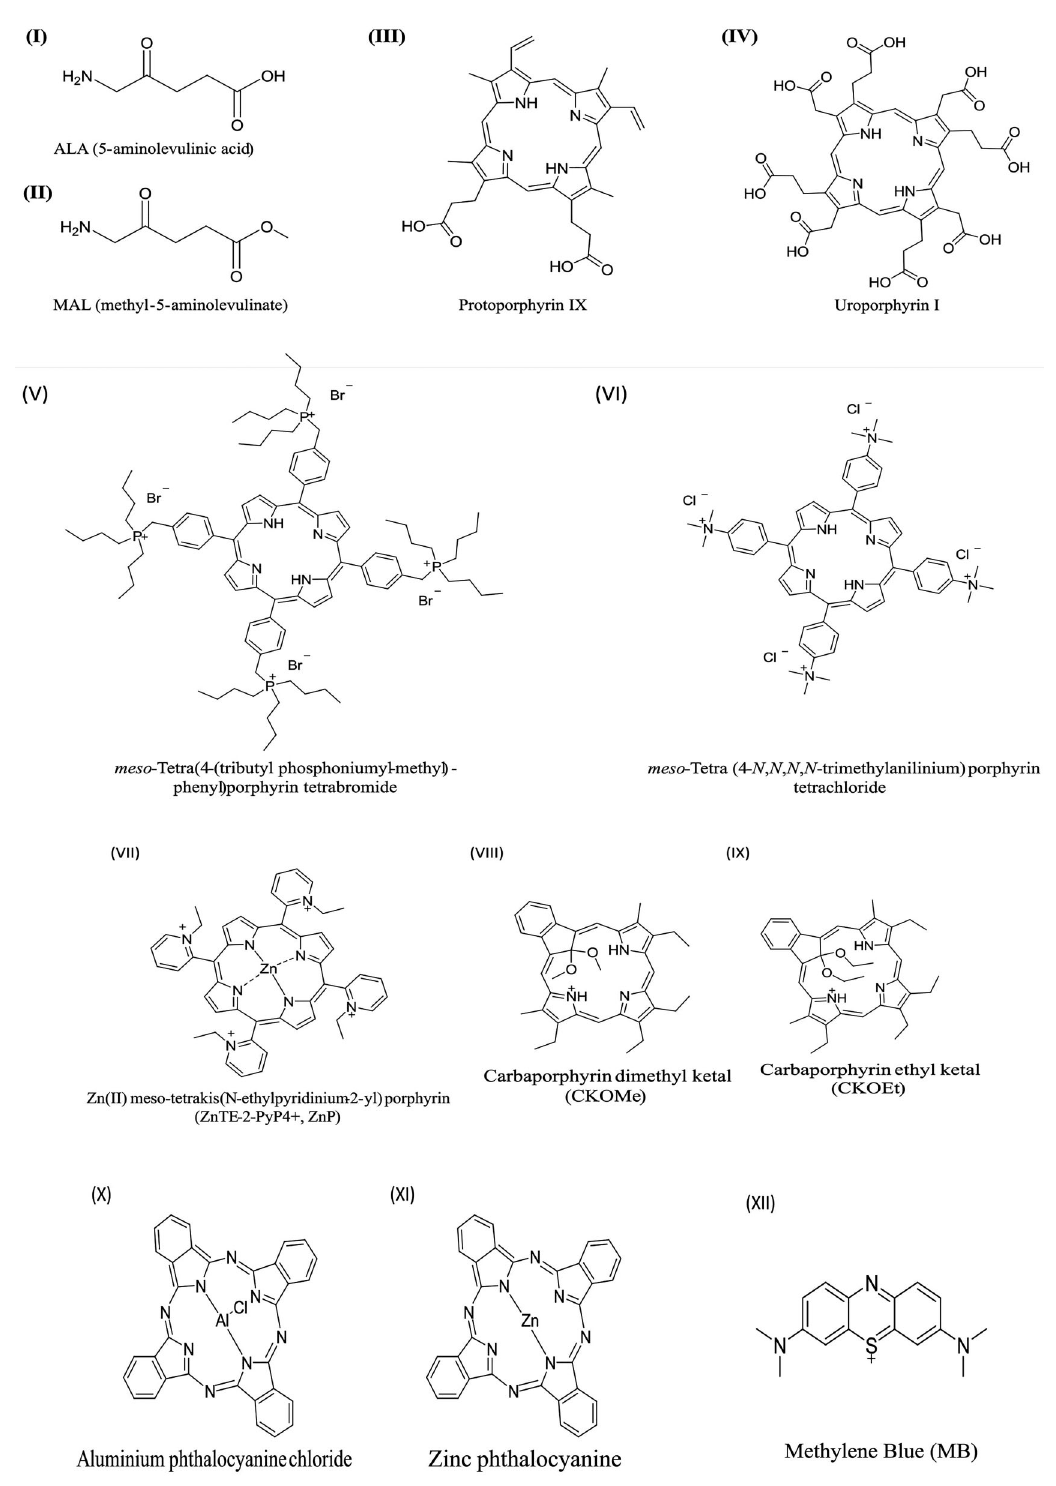
Figure 2. Structure of presented photosensitizers. I – IV , delta-aminolevulinic acid (ALA) and ALA derivatives; V – IX , porphyrins and derivatives; X and XI , phthalocyanines; XII , phenothiazinium